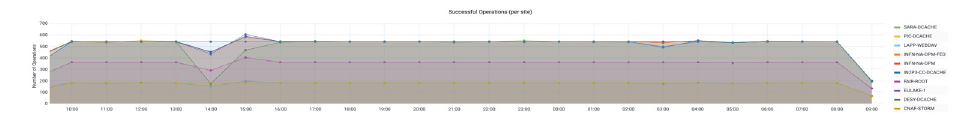
Figure 3: GFAL Successful Operations (per site)